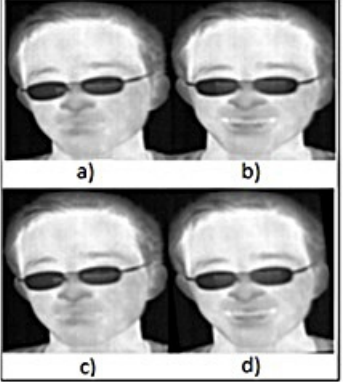
Figure 2. Image registration process: ( a , b ) represents onset and apex thermal images before similarity transformation, respectively; ( c , d ) represents onset and apex images after similarity transformation, respectively.